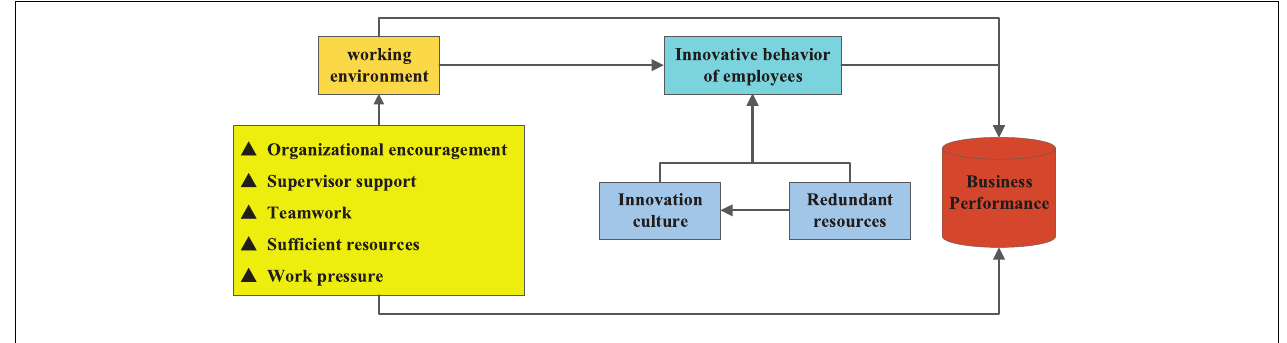
FIGURE 1 | The theory model in the study.